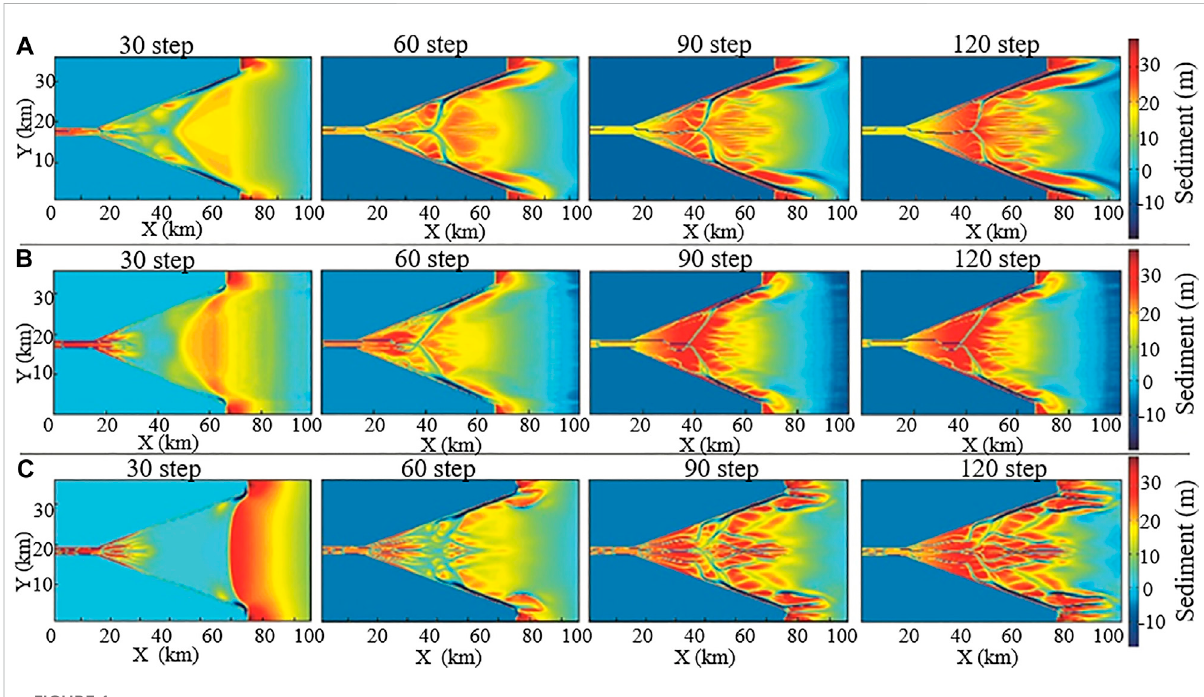
FIGURE 1 Sedimentthicknessoftheestuaryatdifferenttideheights (A) representsthetideat3.4 m, (B) representsthetideat6.8 m,and (C) representsthe tide at 7.2